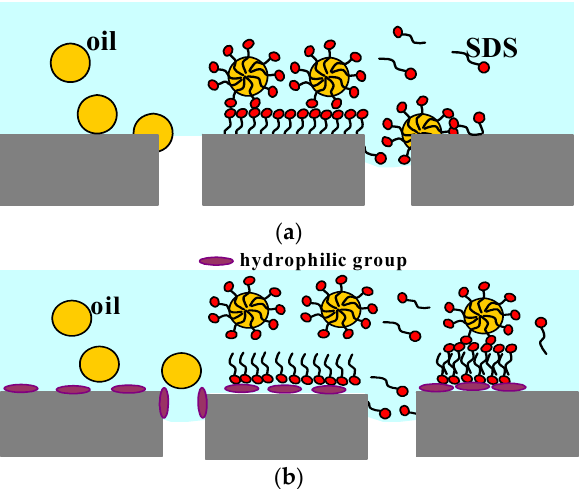
Figure 1. The effect of surface chemistry on the surfactant and oil absorption on the membrane surface: ( a ) new hydrophobic membrane (initial period); ( b ) MD membrane with hydrophilic group formed on the membrane surface during long ‐ term module exploitation.